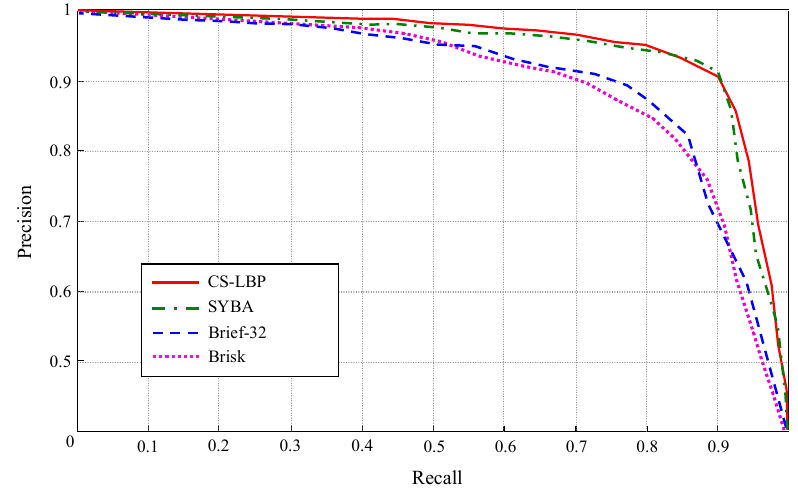
Figure 24. Far-field model performance using different binary descriptors.